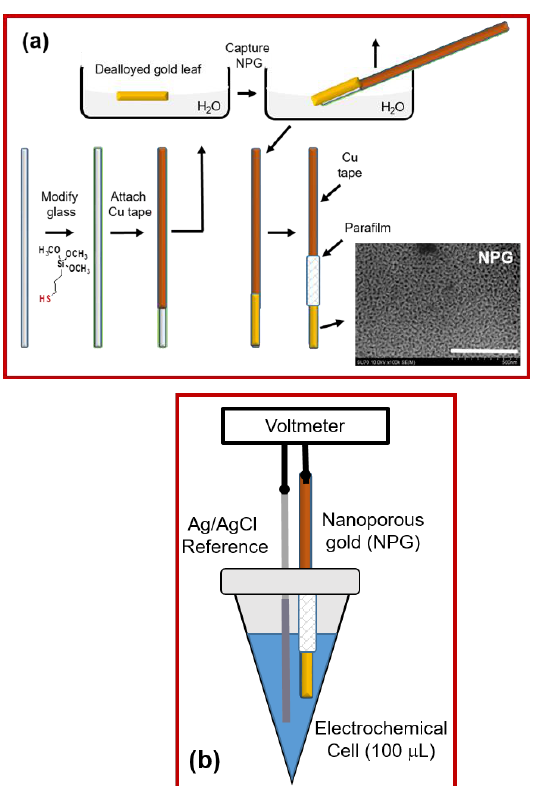
Figure 1. ( a ) Simplified schematic of the fabrication of the miniaturized nanoporous gold electrodes and the corresponding SEM (scale bar is 500 nm). ( b ) Cartoon of the electrochemical cell used to make the potentiometric measurements.